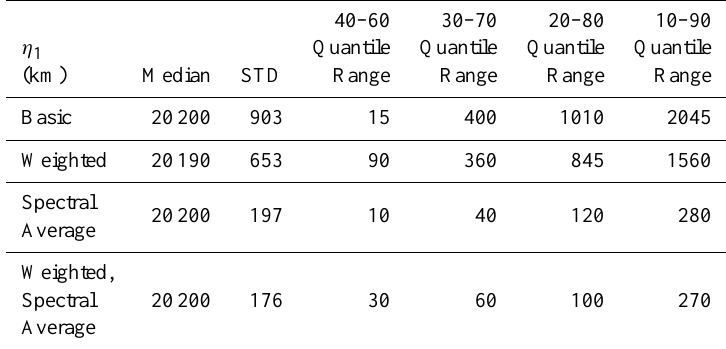
Table 2. Statistics for maximum likelihood estimates of η 1